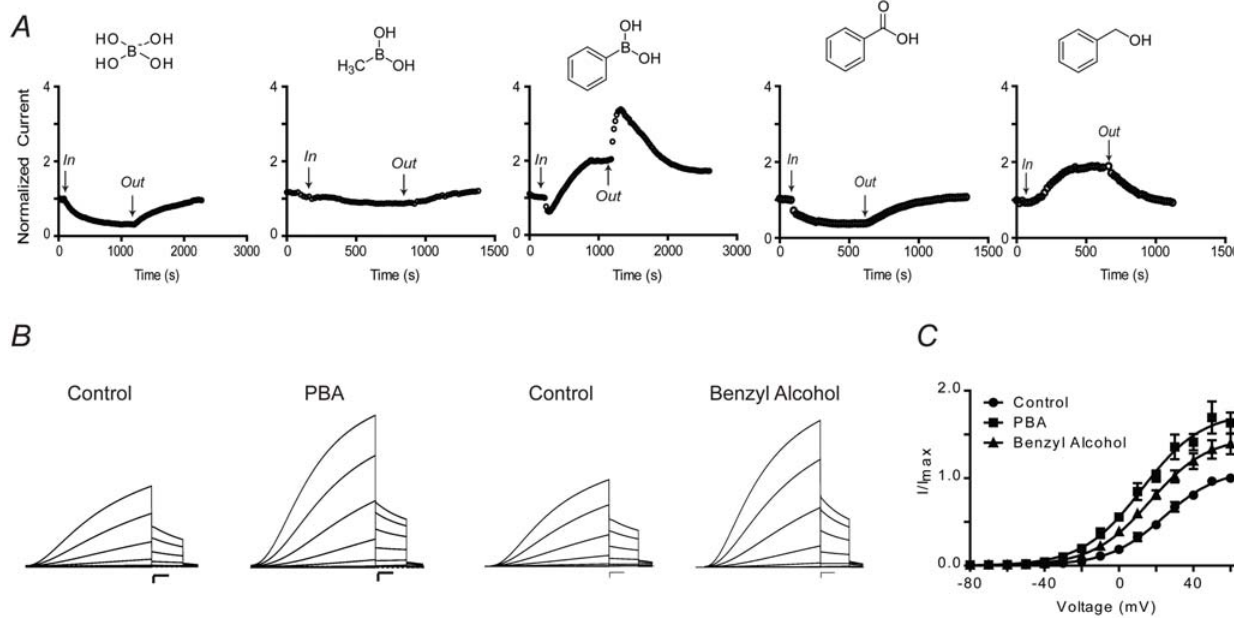
Figure 1. Modulation of Q1/E1 channels by boronates. (A) Time course of Q1/E1 current measured in ND96 at + 40 mV at the end of a 2 s pulse. The current was normalized before compound application. Borax reversibly inhibits while methylboronic acid has little to no effect on channel current. Phenylboronic acid (PBA) initially inhibits current and then slowly potentiates. Benzoic acid reversibly reduces Q1/E1 channel current whereas benzyl alcohol reversibly activates the channel complex. (B) Families of currents recorded before and during treatment with PBA or benzyl alcohol. Currents were elicited by 4 s step test potentials from 2 80 to + 60 mV in 10 mV increments from a holding potential of 2 80 mV followed by a tail pulse to 2 30 mV. Dashed line indicates zero current. Scale bars represent 1 m A and 0.5 s. (C) Voltage-activation curves for Q1/E1 calculated from tail current analysis. Solid curves represent Boltzmann fits to the data. Data are presented as the mean 6 SEM (n=10).